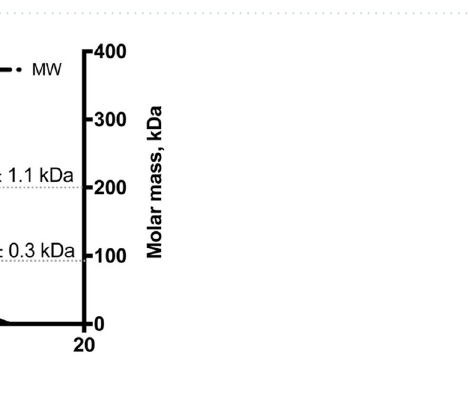
Figure 5. MALS coupled to SEC analysis of the two proMbxA species separated via SEC (blue line peak 1 of Fig. 4, black line peak 2 of Fig. 4). The calculated molecular weight of 201.5 ± 1.1 kDa of the first peak (blue) corresponds to a dimer of proMbxA (theoretical MW (6H-MbxA) 2 = 201.2 kDa). The molecular weight of 93.9 ± 0.3 kDa of the second peak (black) confirms a monomeric species of proMbxA (theoretical MW 6H-MbxA = 100.6